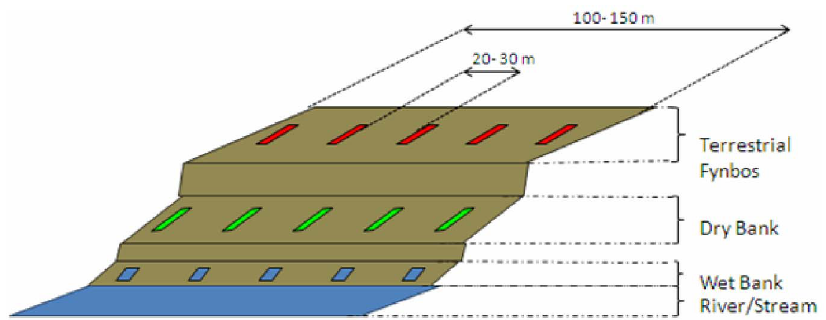
Figure 1. Schematic representation of the lateral zones of the riparian sites and the positions of the sample plots. The extent of each lateral zone is variable depending on the specific dimensions of the riparian zone but ranged from 2m to 10m wide.